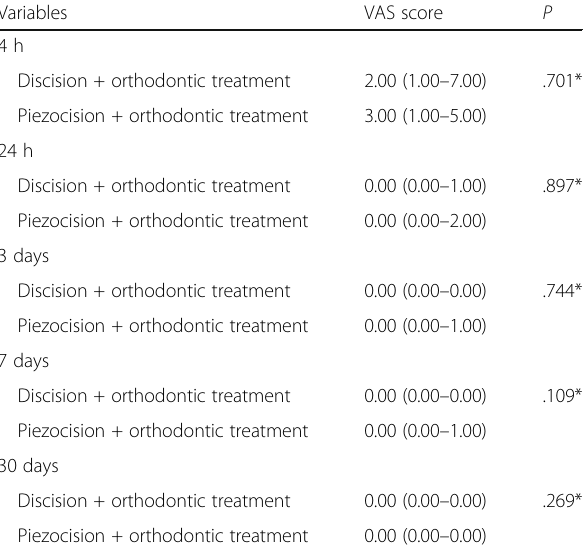
Table 4 Comparison of maxillary VAS scores within experimental groups after the accelerated procedures according to different observation periods Variables